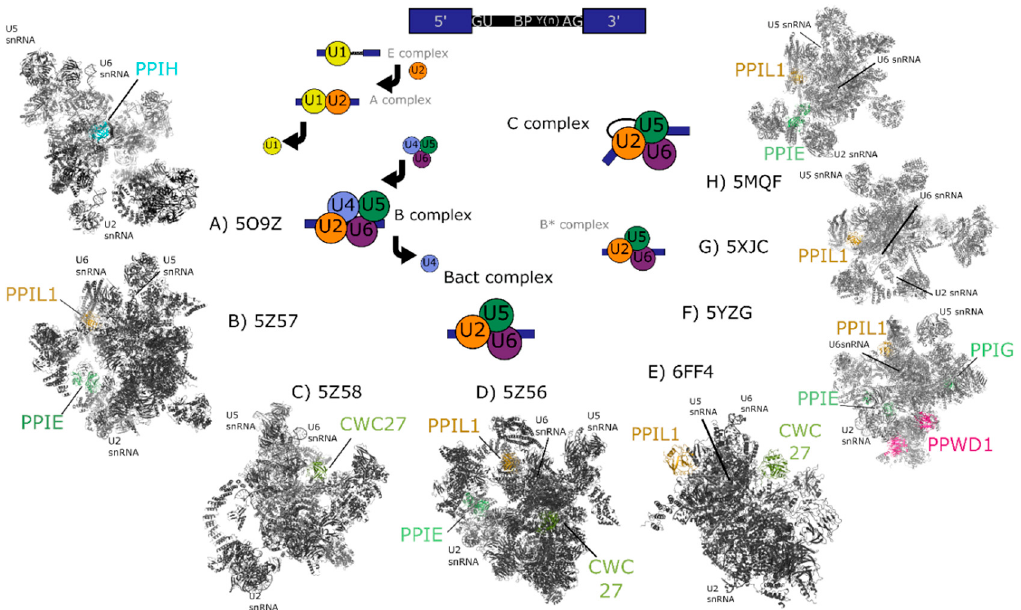
Figure 3. Cryo-electron microscopy structures of spliceosomal complexes. Center, a graphical representation of the canonical metazoan pre-mRNA substrate, including the 5 ′ and 3 ′ exons, the consensus 5 ′ and 3 ′ splice recognition sites, the presence of the branchpoint (BP) that forms the intermediate splicing lariat structure, and the polypyrimidine tract (Y(n)). The classical graphical representation of the splice cycle, shown in the center of the figure, follows the association and dissociations of uridine-rich small nuclear RNAs (U-snRNAs) to characterize the splicing intermediate (E, A, B, B act , B*) and catalytic (C) complexes. Complexes discussed in the text are shown on the outside of the splice cycle, with spliceophilins labeled and highlighted in color. The key U snRNAs U2, U5, U6 are present in all structures, and their rough positions labeled in each structure. The structures are roughly aligned to the part of the splice cycle they are thought to represent: B complex